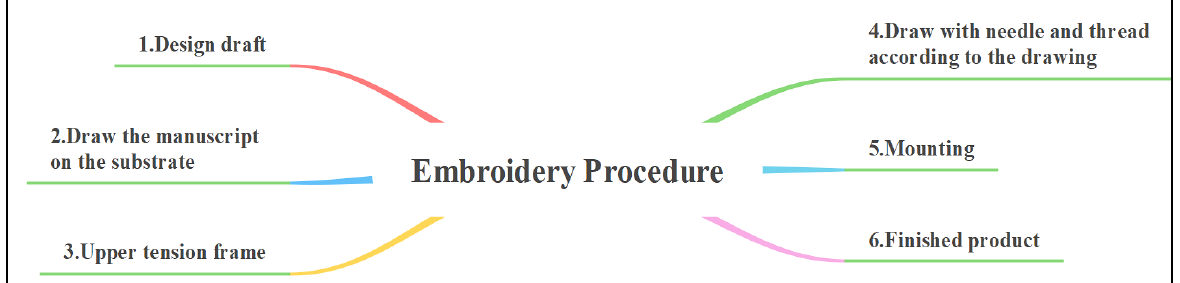
Figure 8. Experience flow chart of Shu embroidery